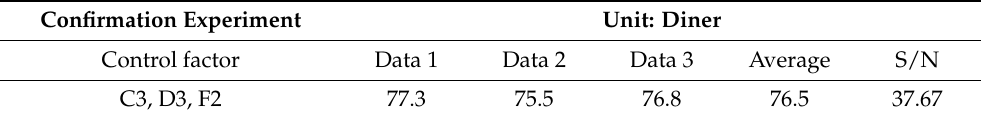
Table 6. The confirmation experiment of the yarn count (unit: Diner).